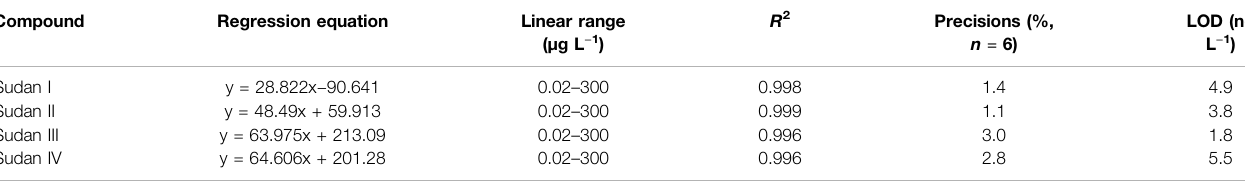
TABLE 1 | Analytical performances of methods. Compound